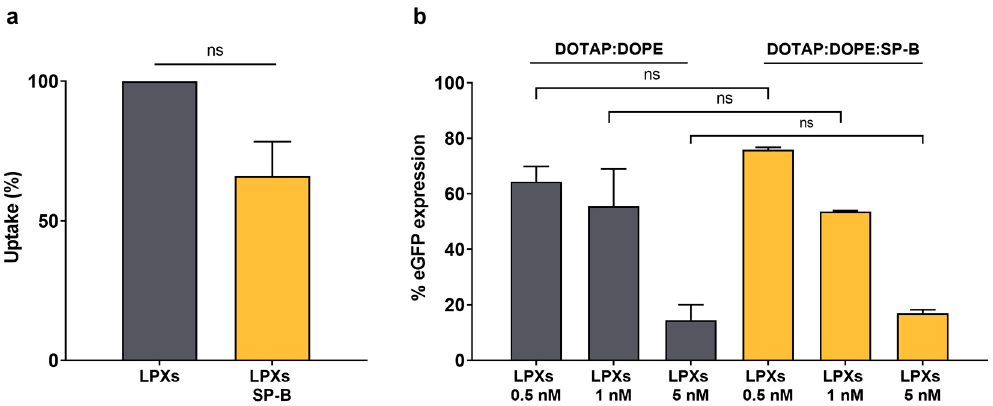
Figure 7. Evaluation of SP-B e ff ect on DOTAP:DOPE liposomes for siRNA delivery in H1299_eGFP cells. ( a ) Cellular uptake and ( b ) gene silencing potential of DOTAP:DOPE LPXs (final concentrations siRNA are 0.5, 1 and 5 nM) with and without SP-B (1 wt%). The inclusion of SP-B in the cationic liposomal formulation does not result in any enhanced delivery e ff ect. For uptake data, statistical analysis was performed using a one sample t -test. Data are represented as the mean ± SD ( n = 2) and statistical significance is indicated (ns = not